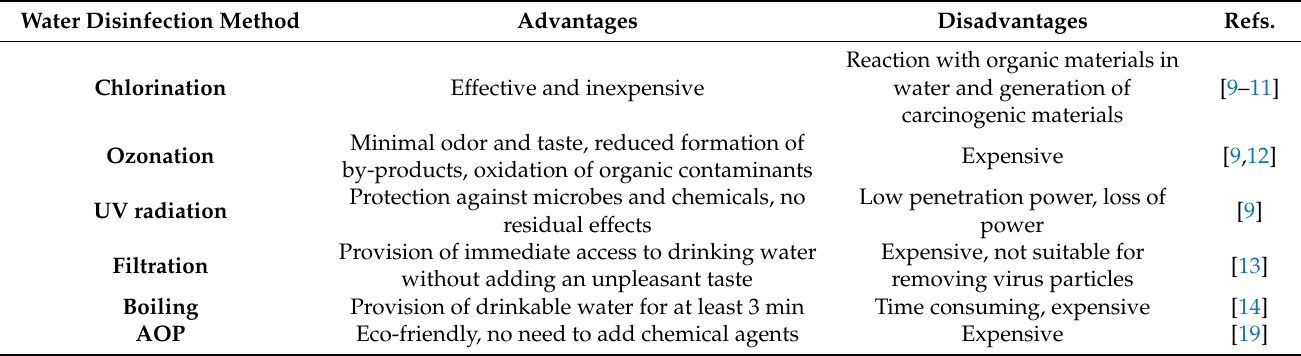
Table 1. Advantages and disadvantages of water disinfection